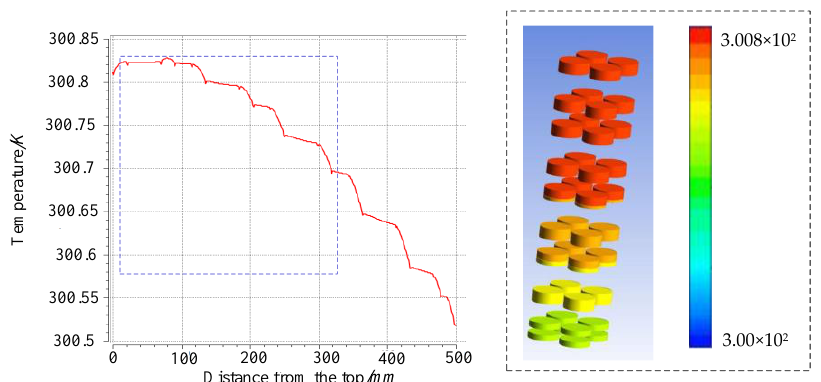
Figure 5. Axial temperature distribution of valve plate column.